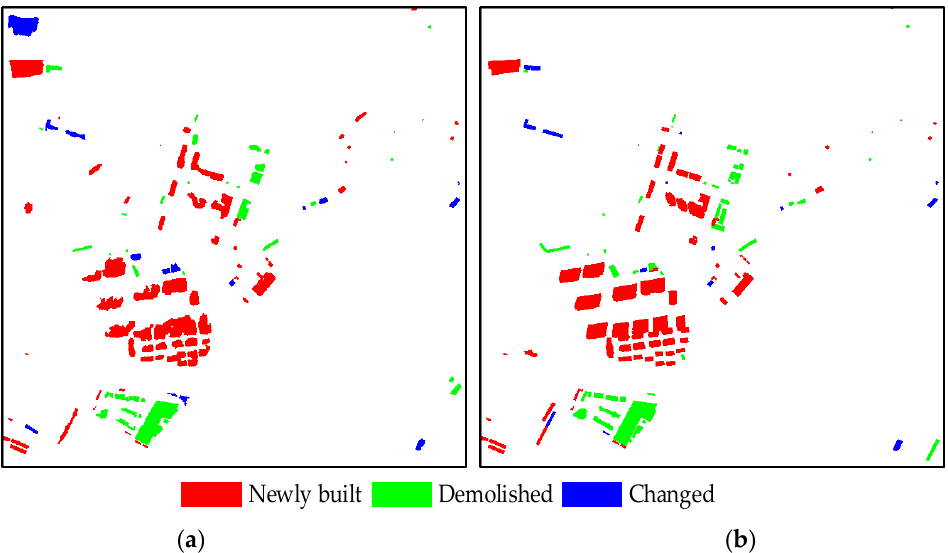
Figure 14. Results of building change detection using ( a ) the proposed method and ( b ) ground truth on Dataset 2.